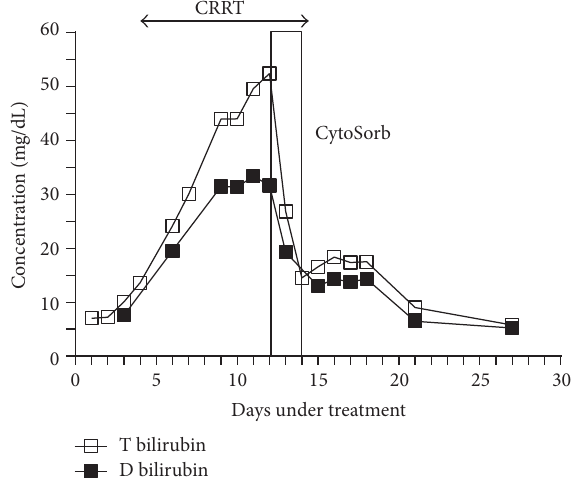
Figure 1: Level of total and direct bilirubin 48 hours before, during, and 48 hours after CytoSorb.